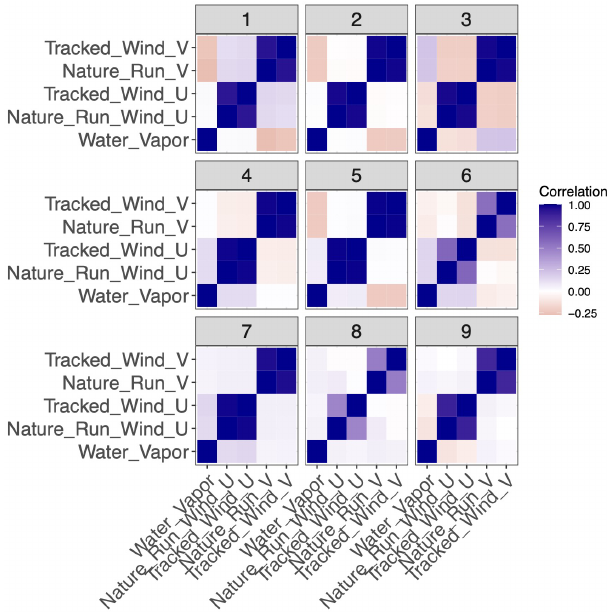
Figure 10. Correlation matrix between each clustered element for each identified cluster in the original training dataset. Each sub- panel refers to a specific